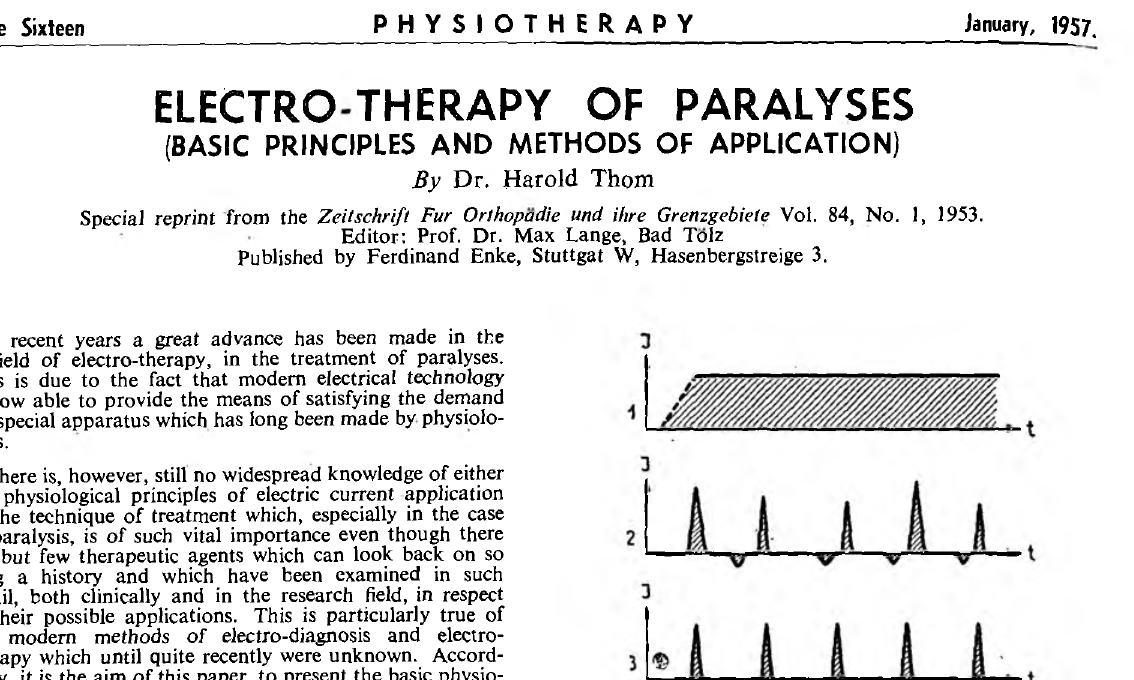
Fig. 1. (Fig. 1.) 1.—Galvanic current, constant D.C. 2.—Faradic current, original form, produced by an induction coil, entirely irregular, not measurable. 3.—Triangular impulse sequence, corresponding to faradic current, exactly defined and measurable.